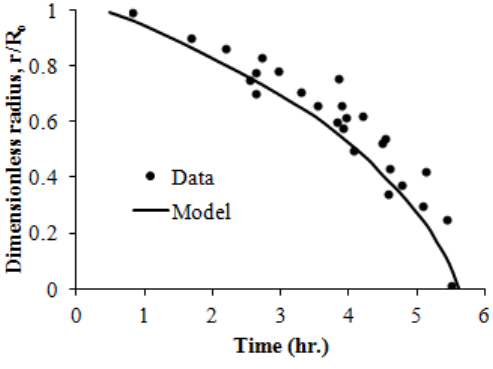
Figure 38. The location of the drying front as a function of time [74]. Energies 2015 , 8